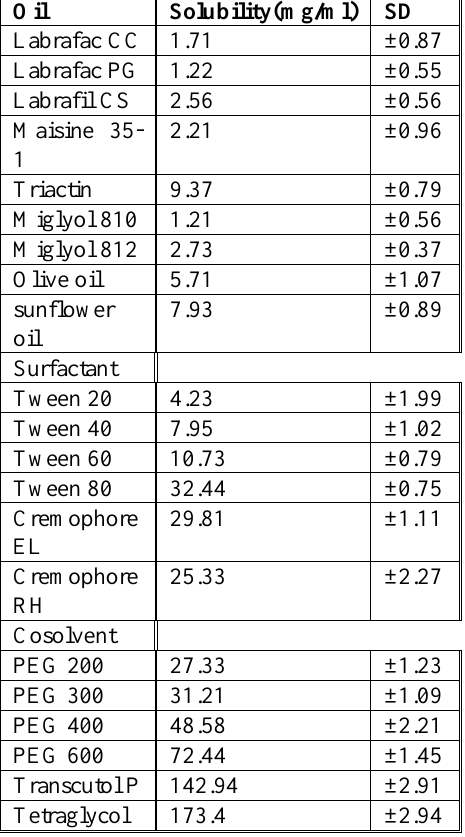
Table 3. Saturation solubility study for different oils, surfactants, and cosolvents with respect to CC.